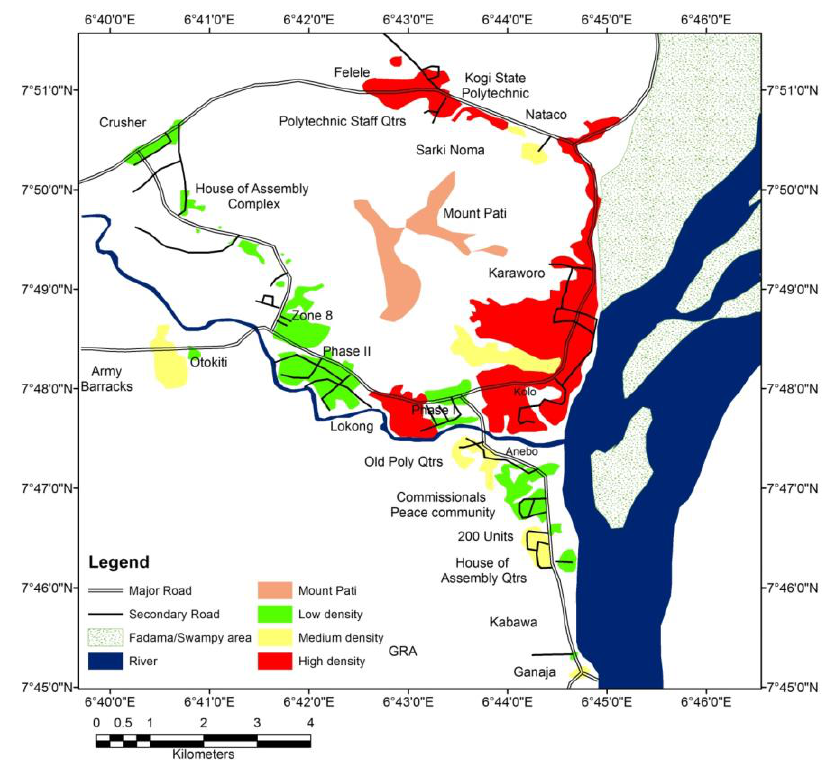
Figure 2. Map of the study location showing the geographical coordinates.